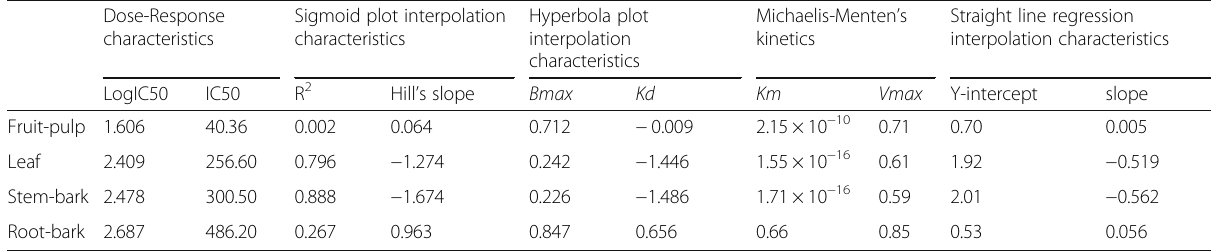
Table 1 Dose-response characteristics of the influence of Annona muricata methanolic extracts on plasma amylase activity Dose-Response characteristics